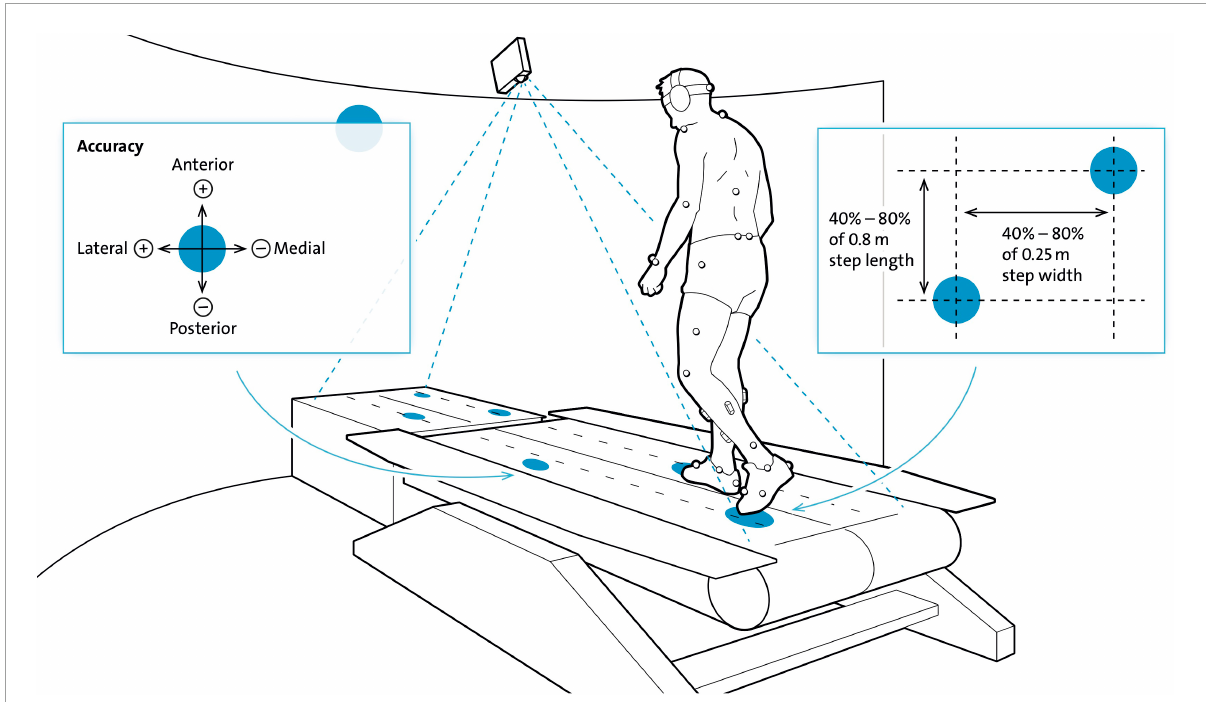
FIGURE1 Experimental set-up for the Target walking task. Participants walked on moving white circular targets (diameter = 10 cm, here blue) projected on the black treadmill (here white) with their preferred walking speed. Circular targets moved at the same speed and thus, gave the impression of being stationary. Step length and width were changed based on a variability of 40–80% of 0.8 m and 40–80% of 0.25 m, respectively. Participants had to precisely step on to the center of the targets which was tracked by a reflective marker placed on the second toe. Accuracy of foot placement was recorded in the anterior-posterior (AP) and medio-lateral (ML) directions. The harness that was worn for safety and the handrails are not shown in this schematic figure of the Motek GRAIL treadmill system. Modified from Mohammadzada et al.